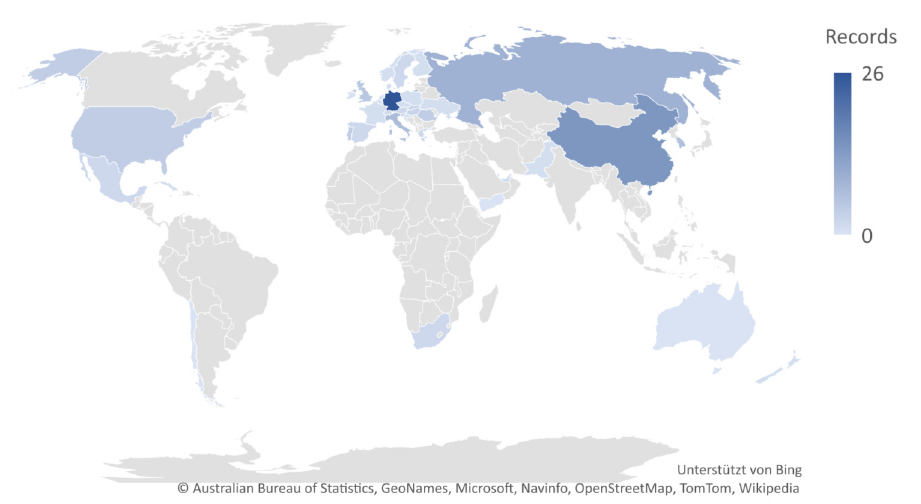
Figure 5. Heatmap of records by country.